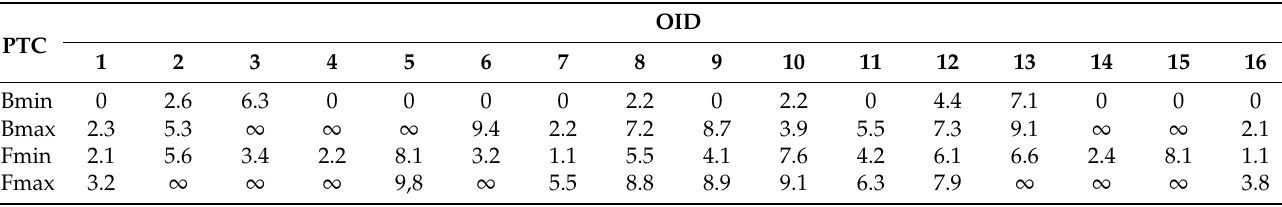
Table 4. Time constraints of production time (PTC = production time constraints. OID = Production order ID. BMIN = be- ginning time lower limit. BMAX = beginning time upper limit. FMIN = finishing time lower limit. FMAX = finishing time upper limit)